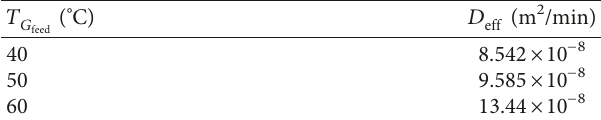
Table 2: Effective mass diffusivity estimated for red araç´a